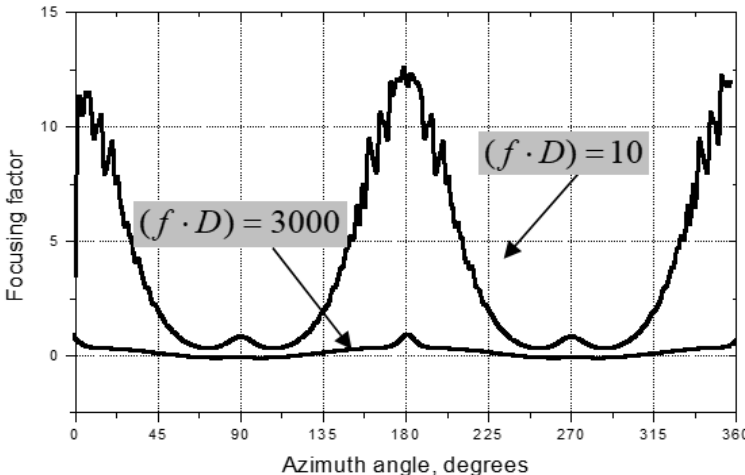
Figure 15. Dispersion of phonon focusing in UD-CFRP.